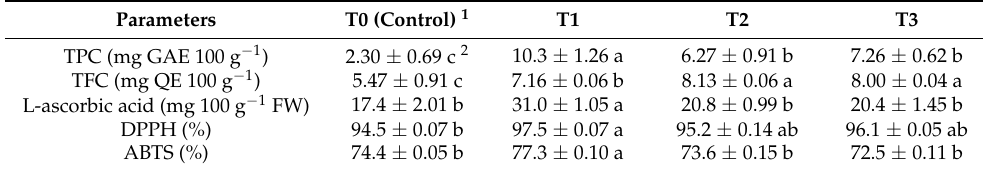
Table 8. Influence of growing media on total polyphenols (TPC), total flavonoids (TFC) and L-ascorbic acid content and antioxidant activity determined by DPPH and ABTS tests of marketable tomato